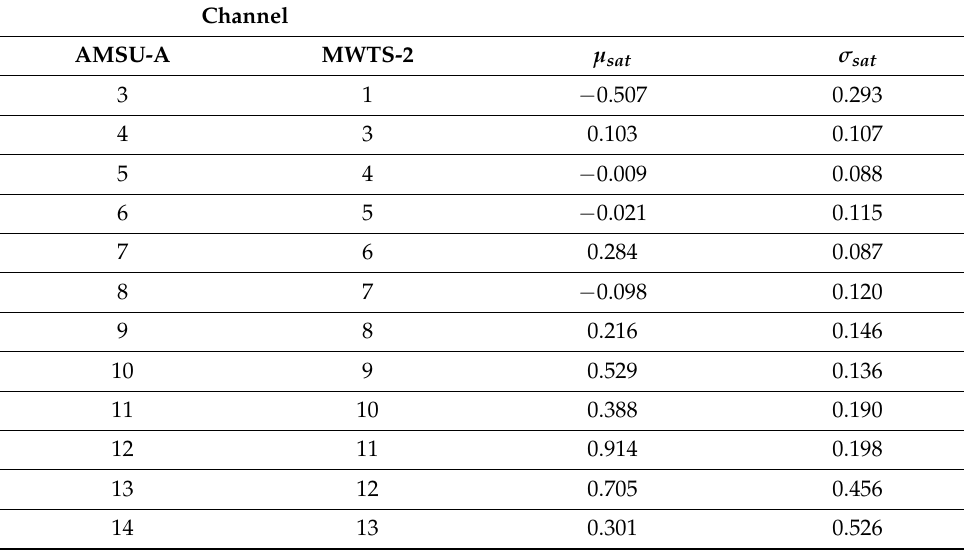
Table 4. Same as Table 3 except for FY-3D MWTS-2 and NOAA-18